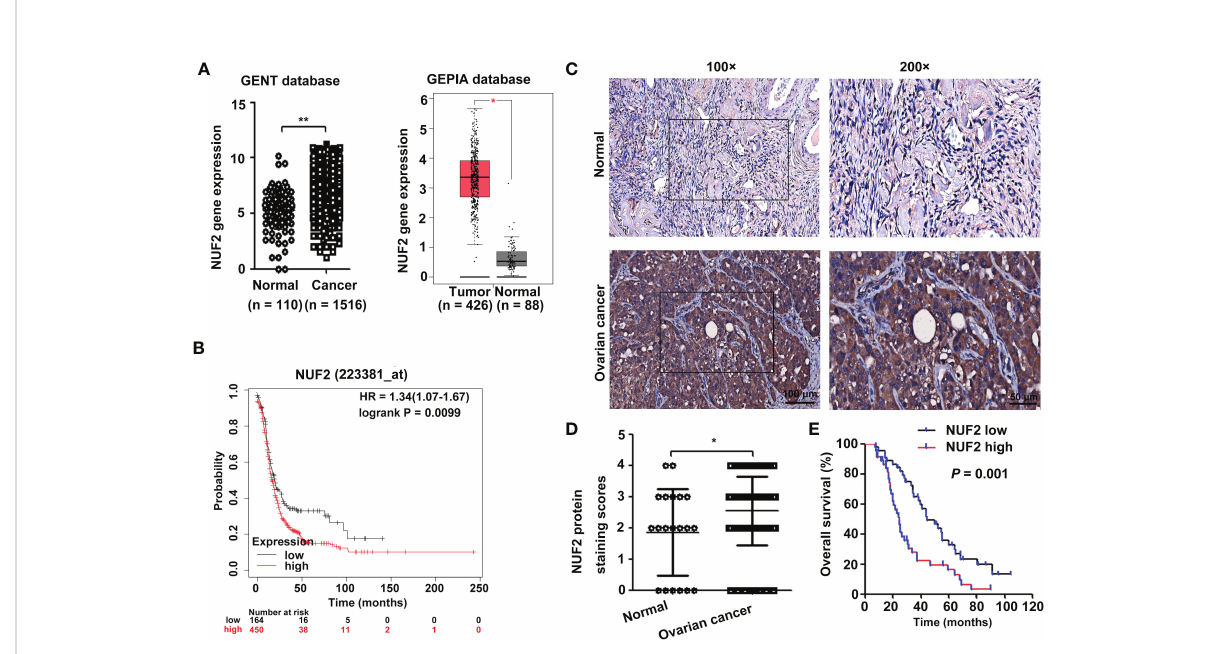
FIGURE 1 NUF2 expression is upregulated in EOC tissues. (A) NUF2 gene expression was determined in two databases (GENT2 and GEPIA). * P < 0.05, ** P < 0.01. (B) Kaplan-Meier analysis based on Kaplan – Meier Plotter databases showed that patients with low NUF2 levels exhibited signi fi cantly better overall survival than patients with high NUF2 levels. (C) Representative images of IHC staining of NUF2 expression in EOC tissues and normal ovarian epithelial tissues are shown in the upper panel (original magni fi cation, left × 100, right × 200). (D) NUF2 protein expression was signi fi cantly higher in 89 EOC tissues than in 20 normal ovarian epithelial tissues. * P < 0.05. (E) The High NUF2 expression was associated with poor EOC prognosis ( P =